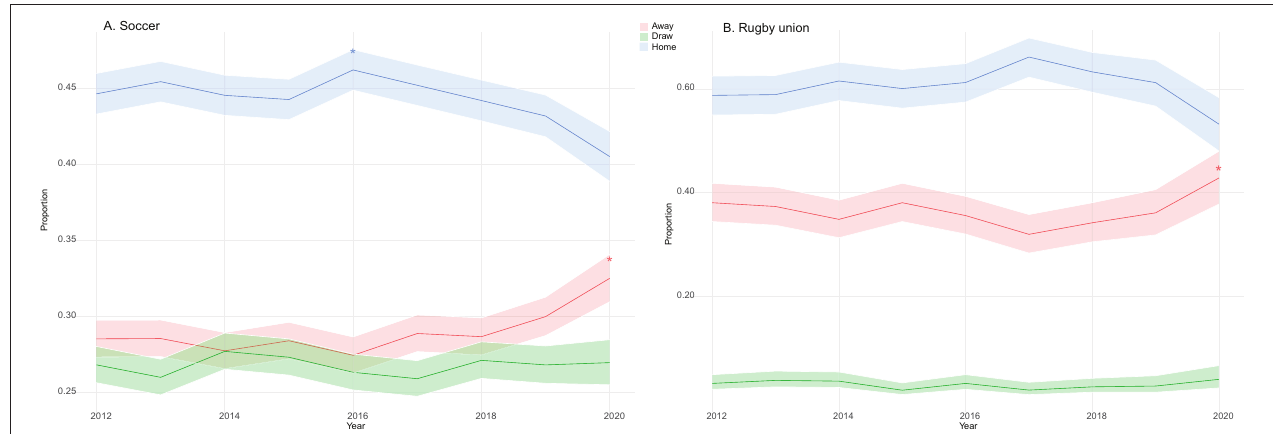
FIGURE 1 | Evolution of the proportion of matches won at home, away, and drawn for the 2012–13 to 2020–21 seasons in (A) soccer and (B) rugby professional